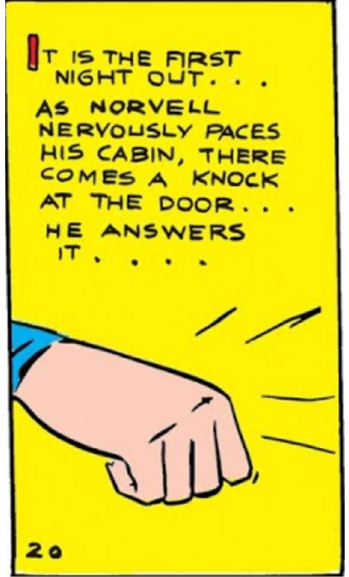
Figure 13. Joe Shuster, Close-Up of Superman Knocking on a Door (panel No. 20), 1938. Siegel and Shuster (July 1938), “Superman”, Action Comics #2 (Siegel and Shuster 1938b, p. 24). © DC Comics.